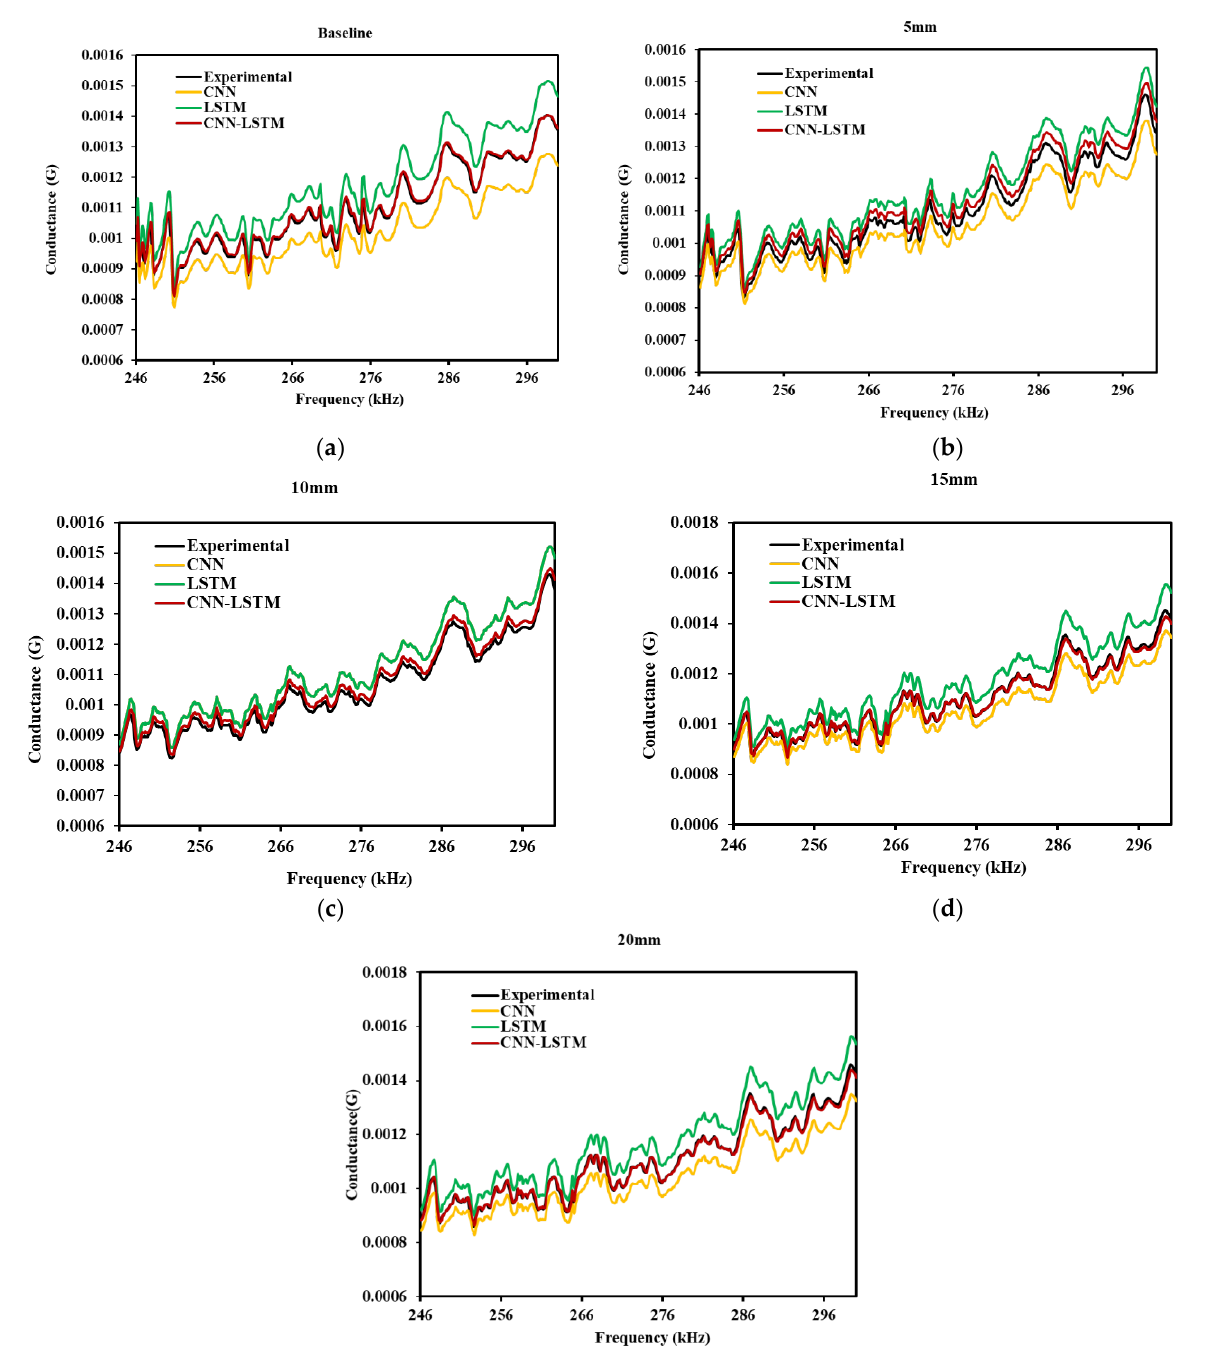
Figure 14. Experimental and predicted deep learning models comparison of Sample 1 ( a )